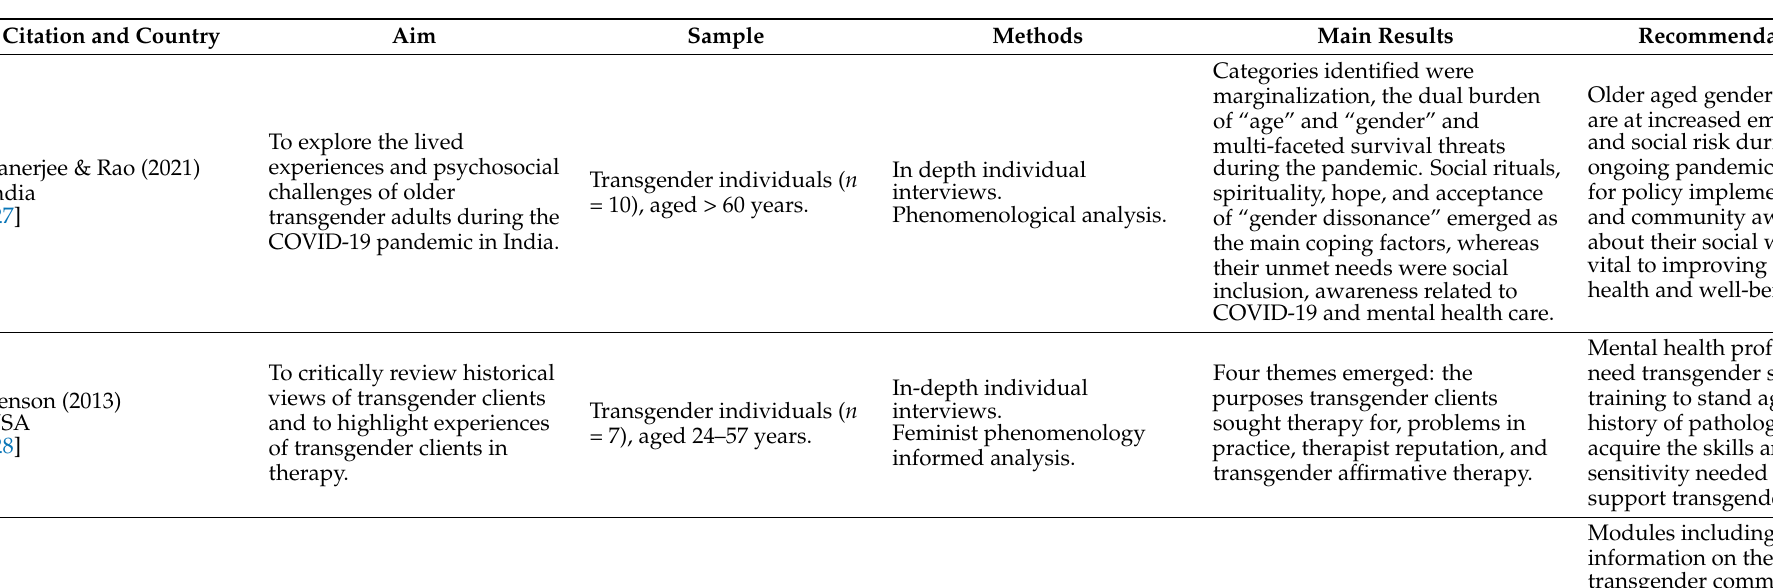
Table 3. Papers included in the review ( n =